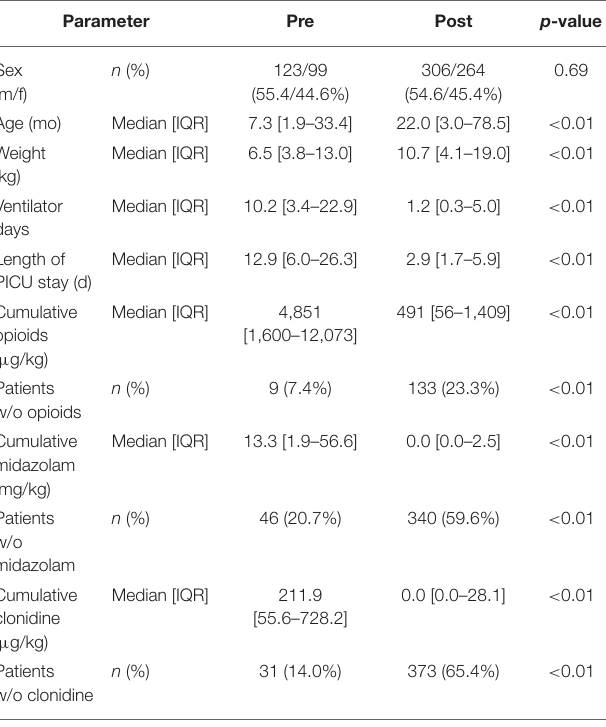
TABLE 6 | Differences of patients’ characteristics between patients with delirium and patients without delirium.